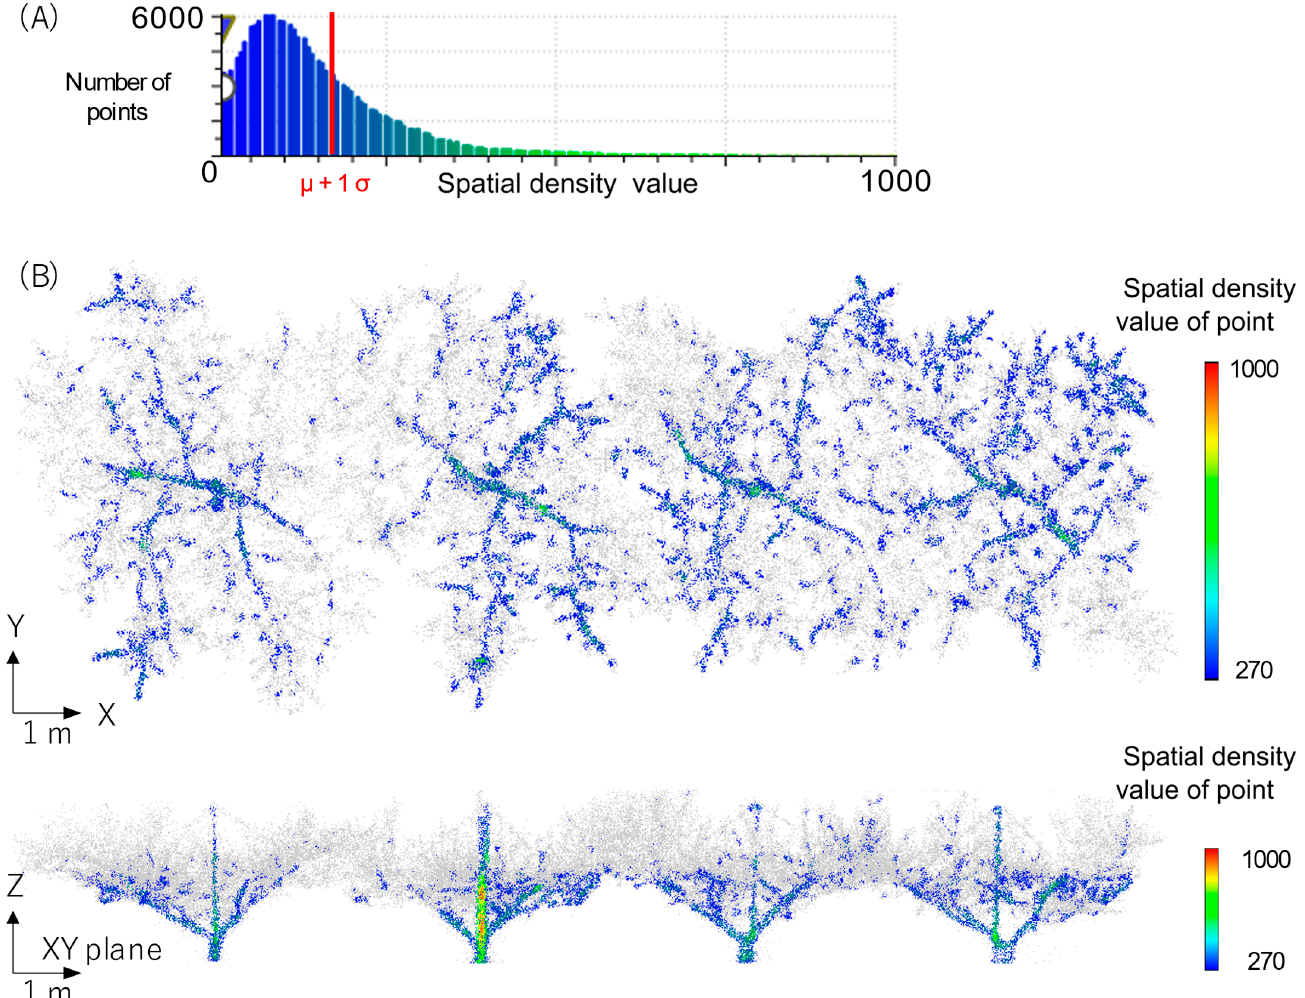
Figure 9. Classification of the branches using the spatial density value of the points (gray points represent fine branches below μ + 1 σ . Other colors represent thick branches above μ + 1 σ ; μ : arithmetic mean; σ : standard deviation). (A) histogram made be the spatial density value of the point. (B) the point cloud model from 24 December 2021 after classification.